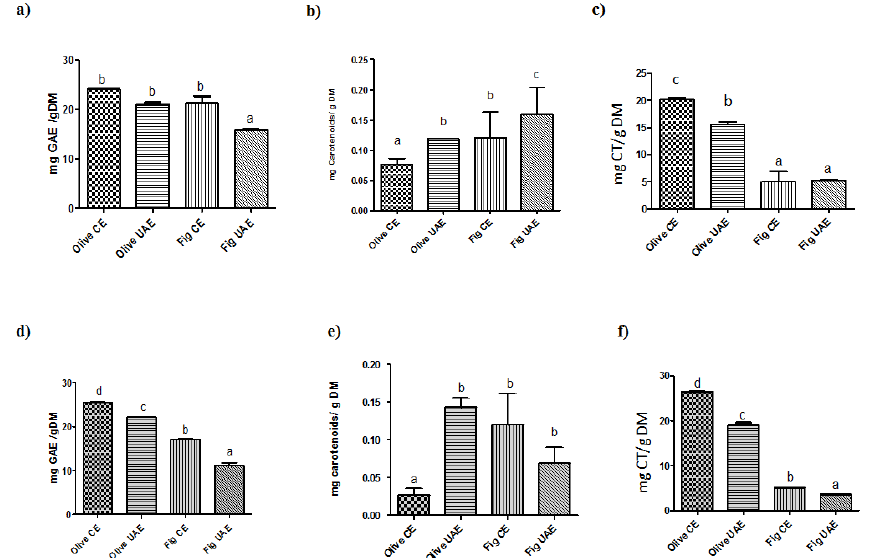
Figure 2. Content of total phenolics, flavonoids and carotenoids in fig and olive leaves extracts after conventional (CE) or ultrasound ‐ assisted (UAE) extraction using either aqueous (a–c) or hydroethanolic (d–f) solvents. Total phenolic content (mg gallic acid equivalents (GAE)/g dry matter (DM)) (a and d), total flavonoid content (mg catechin (CT)/g DM) (b and e) and the carotenoids content (mg carotenoids/g DM sample) (c and f). Bars represent mean and standard error. Different letters comparing treatments represent statistically different mean values ( p < 0.05).